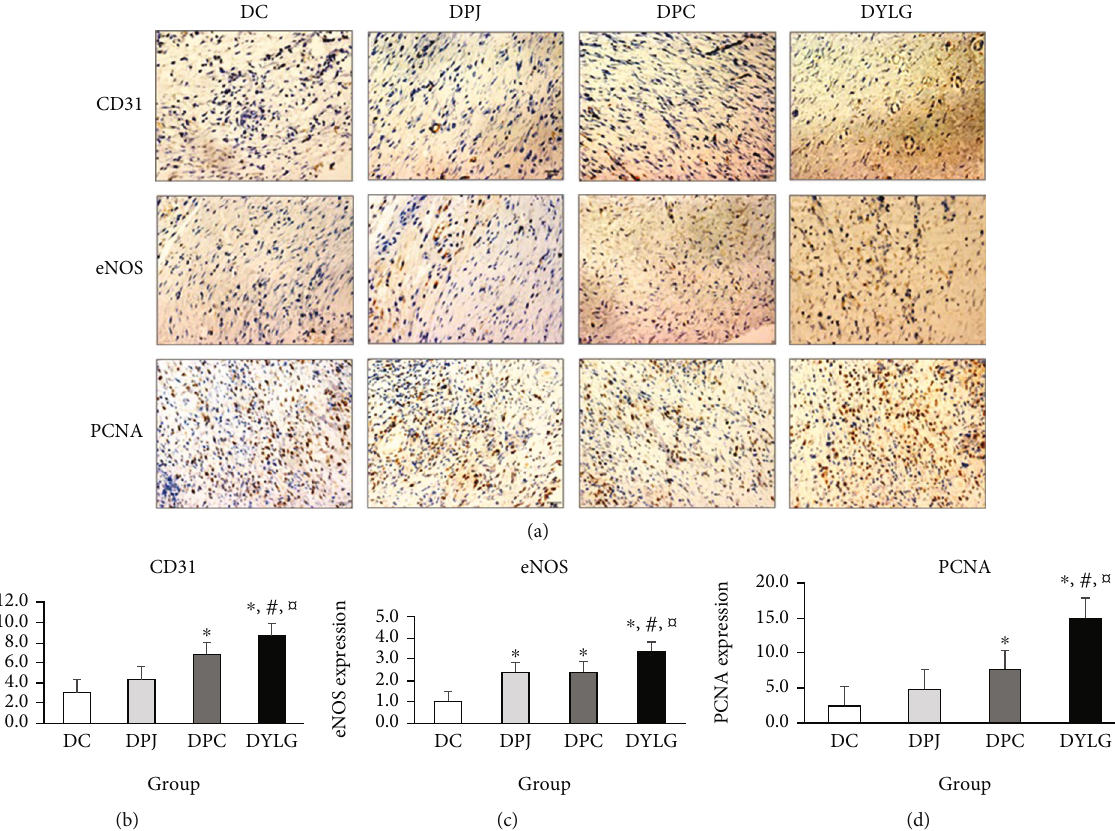
Figure 3: (a) Representative immunohistochemical CD31-, eNOS-, and PCNA-stained wound sections in T2DM groups (DC, DPJ, DPC, and DYLG) (40x magni fi cation and scale bar 50 μ m). (b – d) Representative of the semiquantitative expression of CD31, eNOS, and PCNA, respectively, using ImageJ